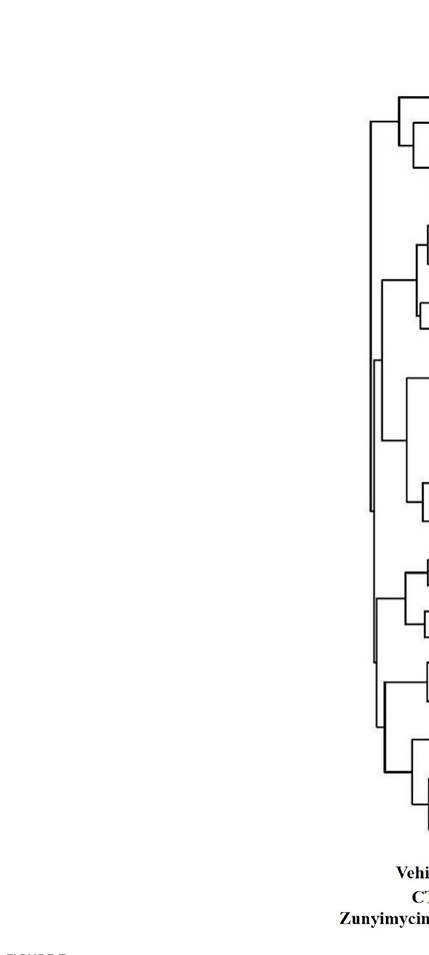
FIGURE 7 Effect of zunyimycin on intestinal fl ora of mice of mice. The intestinal bacteria in the zunyimycin C group changed greatly at the species level. The species abundance of the bacteria that accounted for the most of the total number of bacteria was arranged from high to low, the community structure of different groups of mice varied at the genus level. Compared with AD model mice, change of relative abundance of intestinal fl ora higher than 1 was de fi ned as upregulation and lower than -1 as